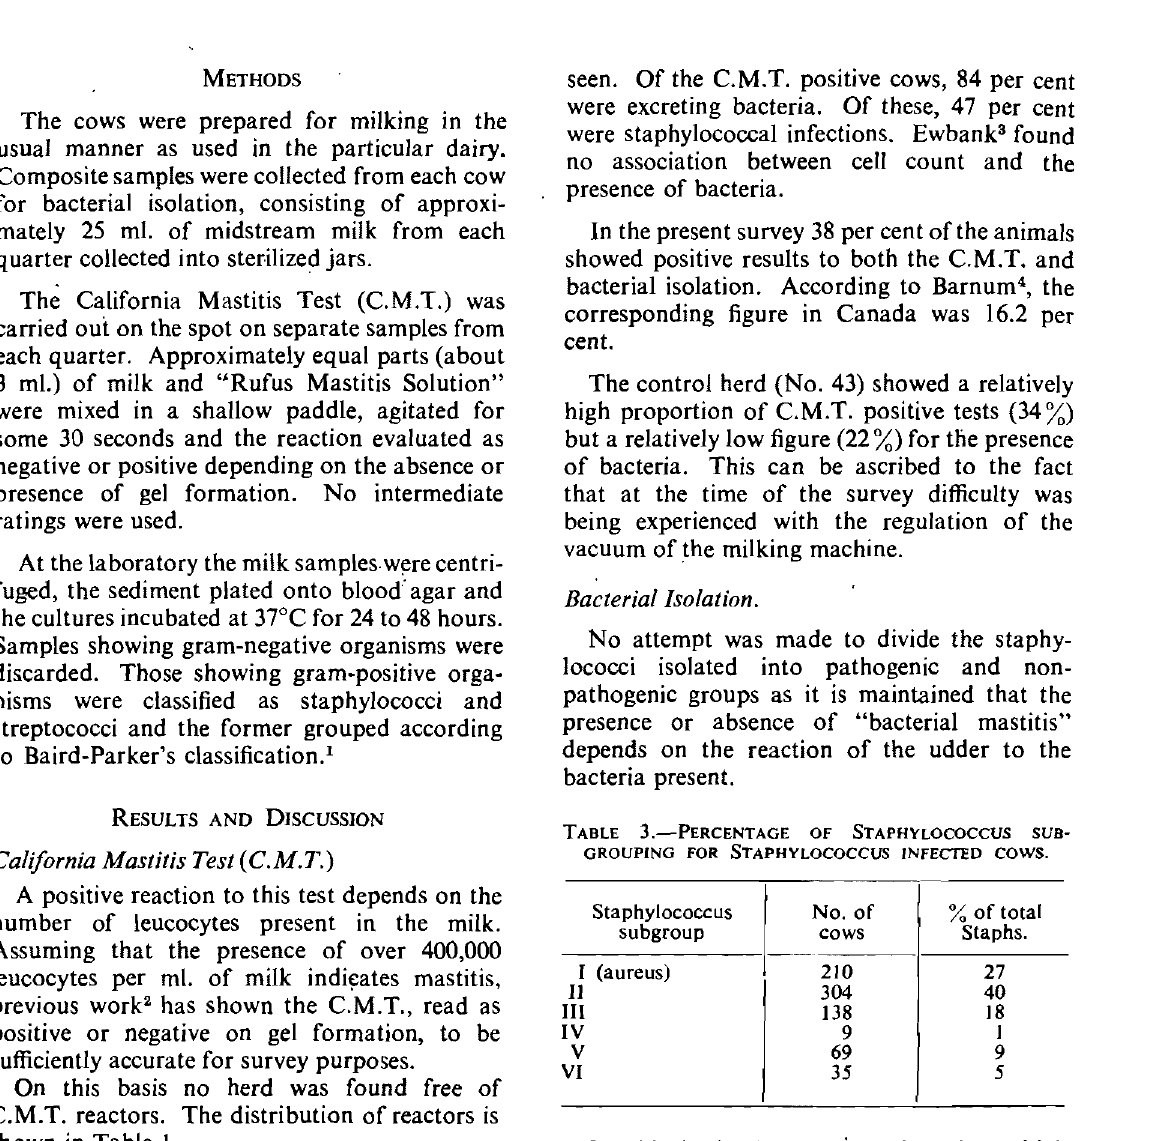
TABLE I.-HERD DISTRIBUTION OF C.M.T. REACTORS.